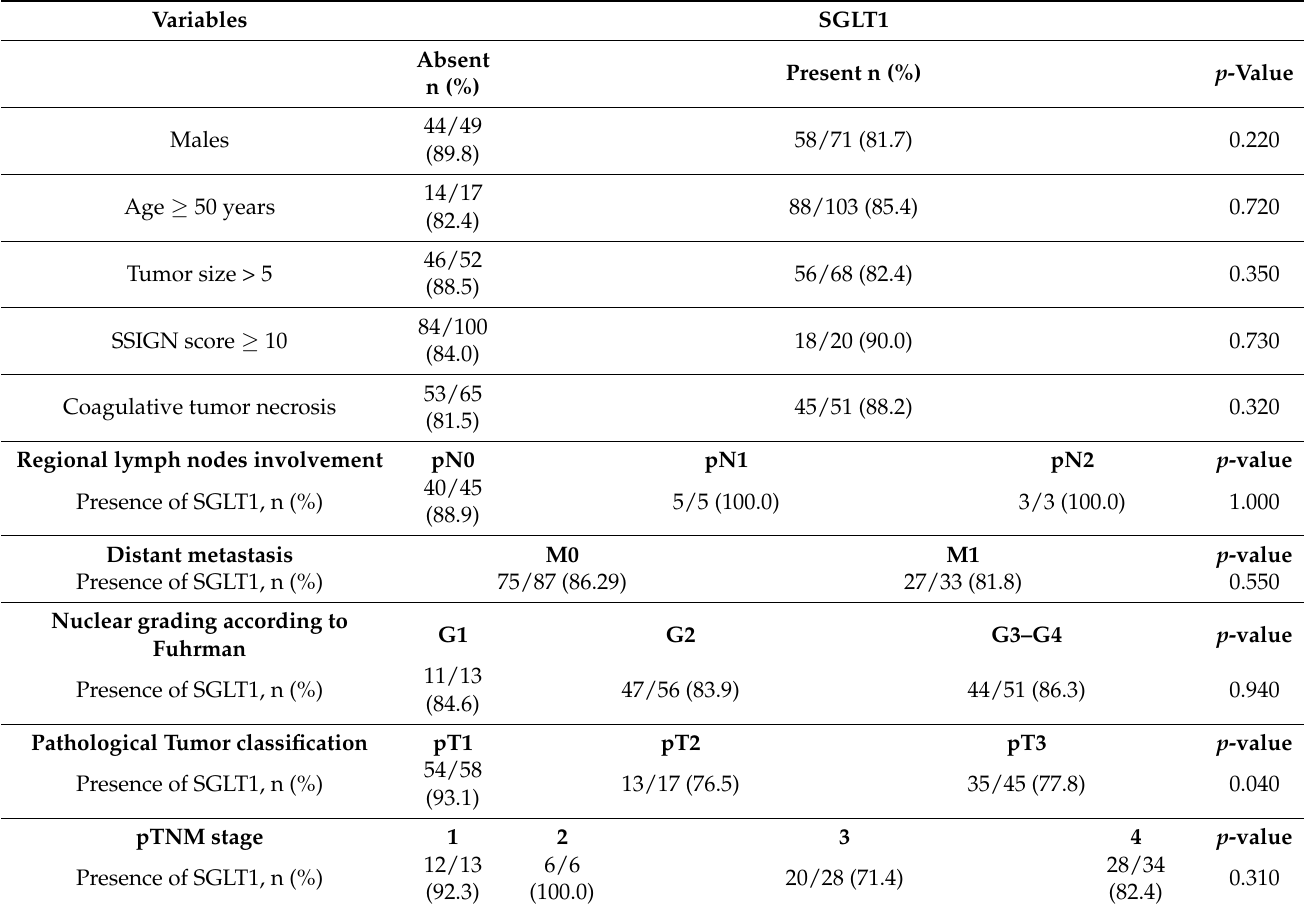
Table 4. Correlation between SGLT1 expression and clinico-pathological features of patients with CCRCC.